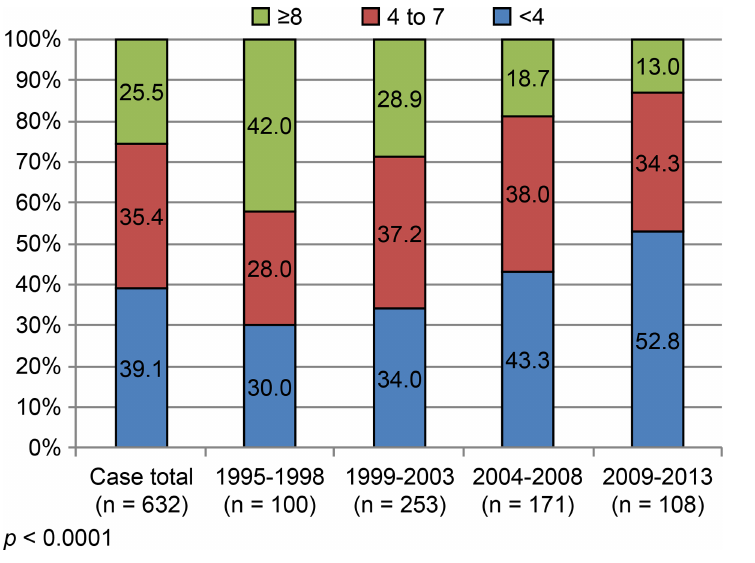
Fig 4. Time (month) from injury to admission (distributions at set